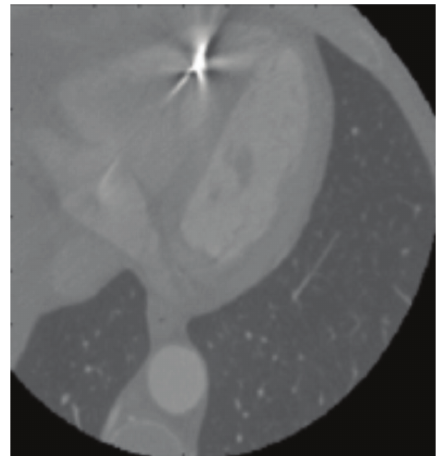
Figure 7: A transaxial image of the CT data volume in which an artifact caused by a metallic object is